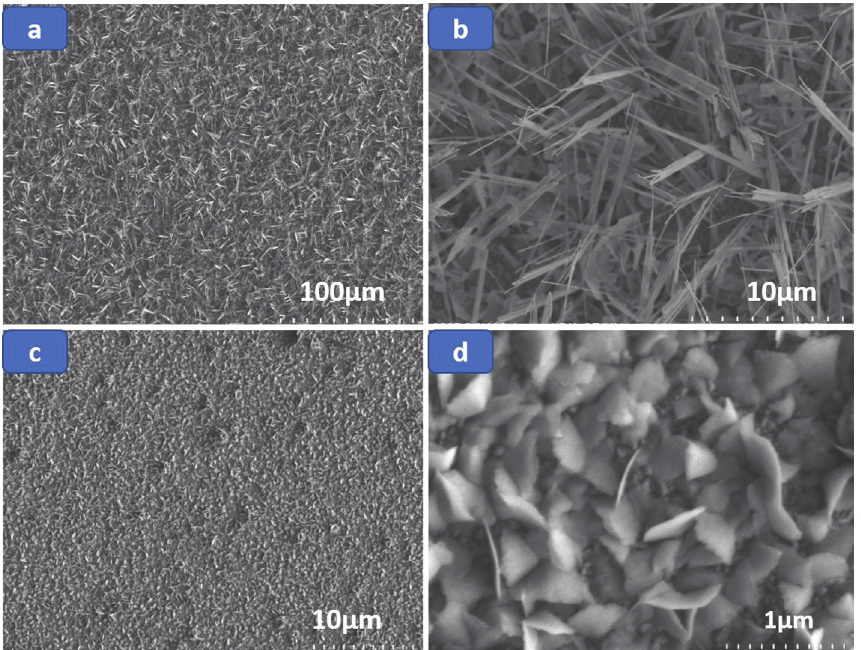
-In S -Bi S composite thin films deposited on FTO substrate using toluene solvent (a) low magnification and 3 2 3 2 3